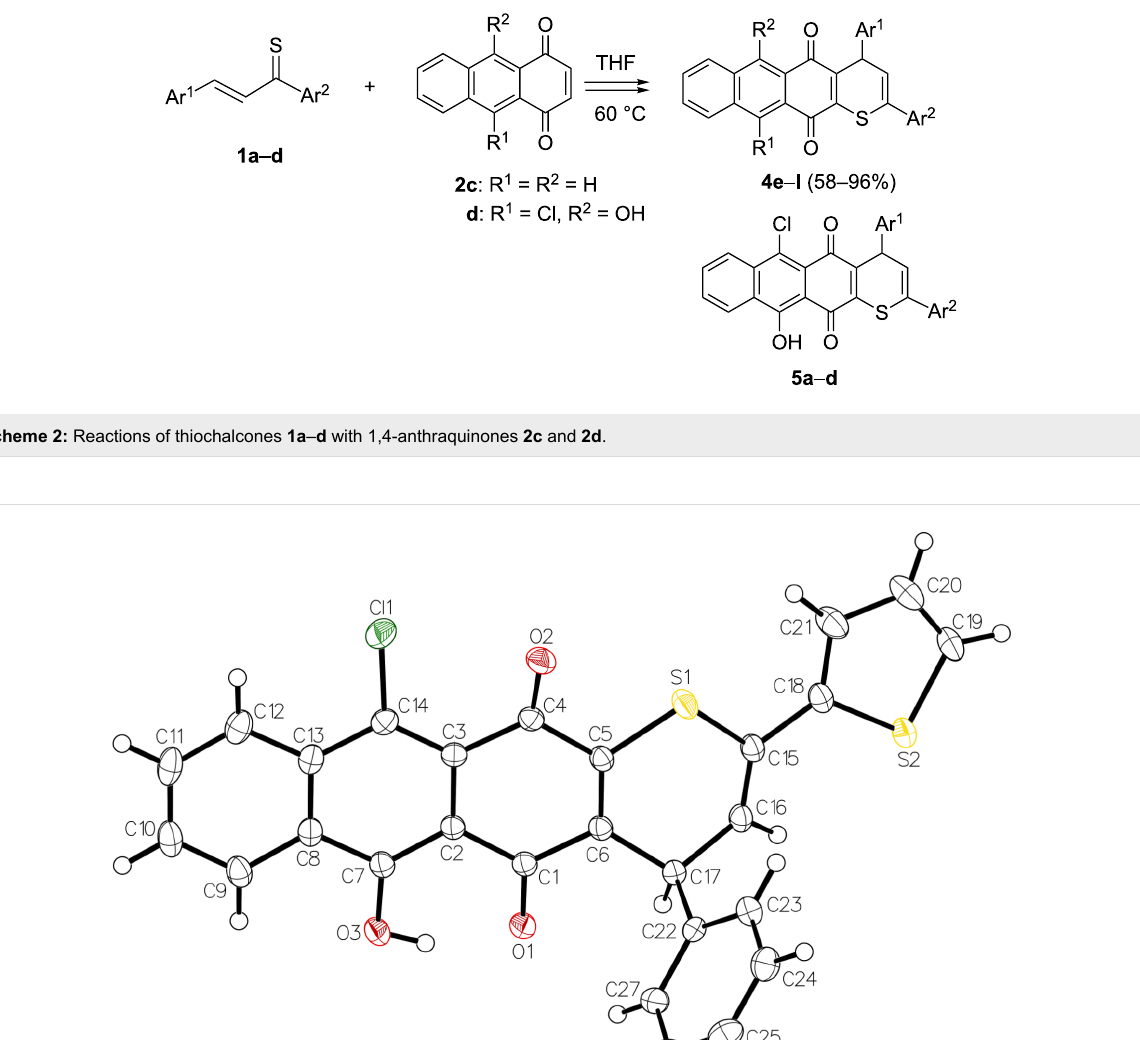
intramolecular hydrogen bond with the adjacent quinoid